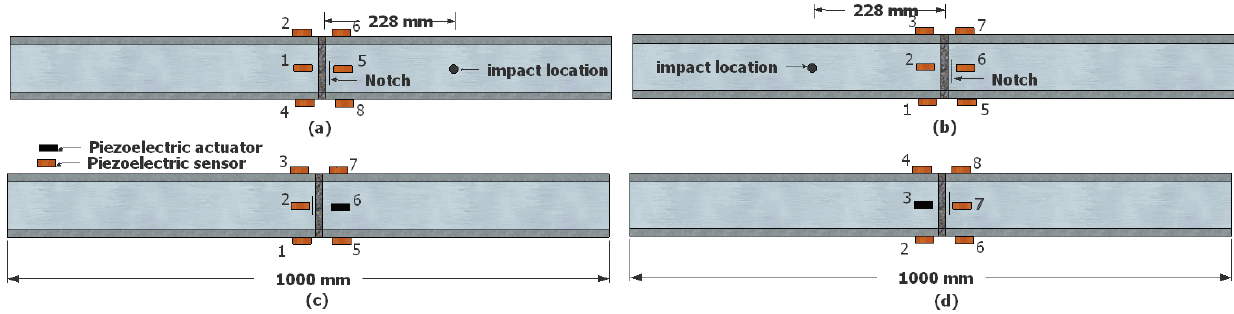
Figure 7. Schematic view of damage scenarios. The pipe was pressurized by air (( a ) and ( c )) and water (( b ) and ( d )).